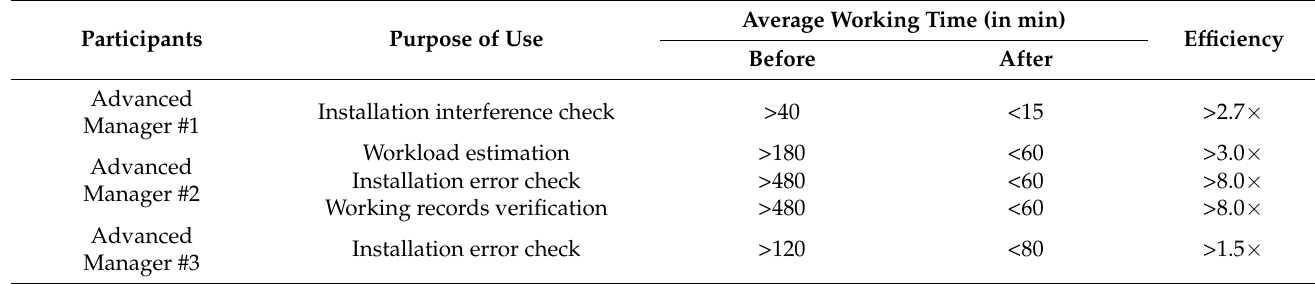
Figure 21. Installation error detection using proposed AR system. ( a ) Positional error detection; ( b ) positional and rotational errors detection; ( c ) rotational error detection. Table 3. Results of a survey on the effectiveness of AR-based inspection.